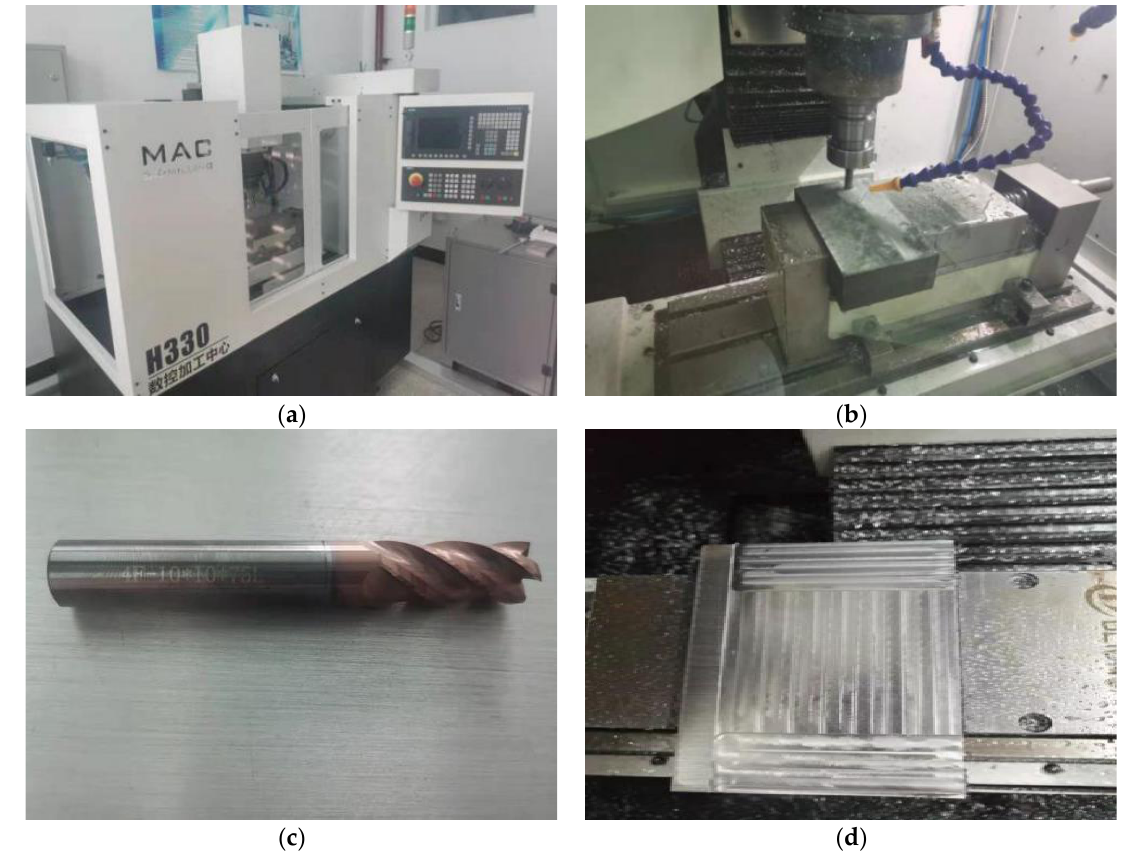
Figure 7. Experimental device. ( a ) CNC machining center. ( b ) The actual cutting test. ( c ) YG8 hard alloy spiral mill tool. ( d ) The finished part.